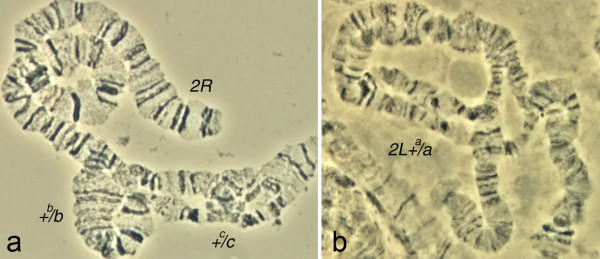
Polymorphic inversions on chromosome 2 of An. gambiae. The heterozygote polymorphic inversions 2Rbc (a) and 2La (b) are shown.